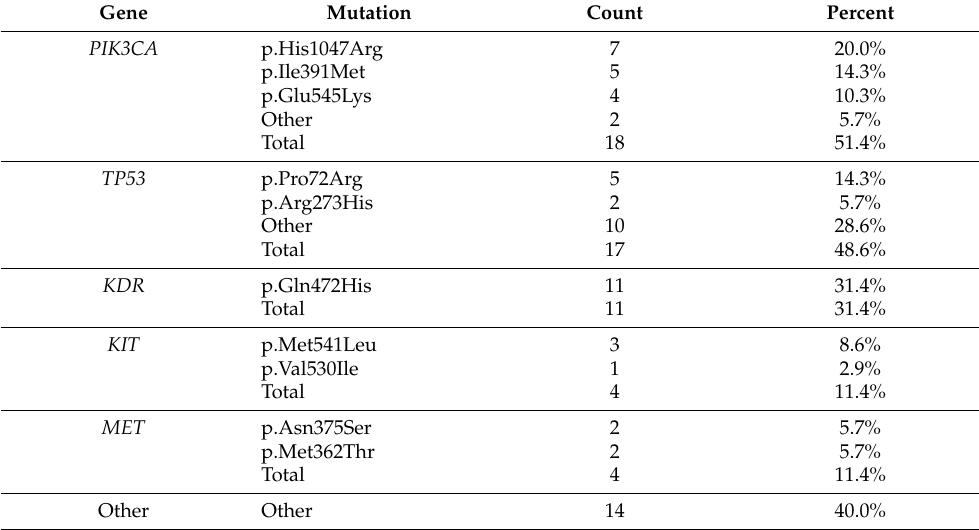
Table 3. Gene Mutation Frequency in Breast Cancer Patients.